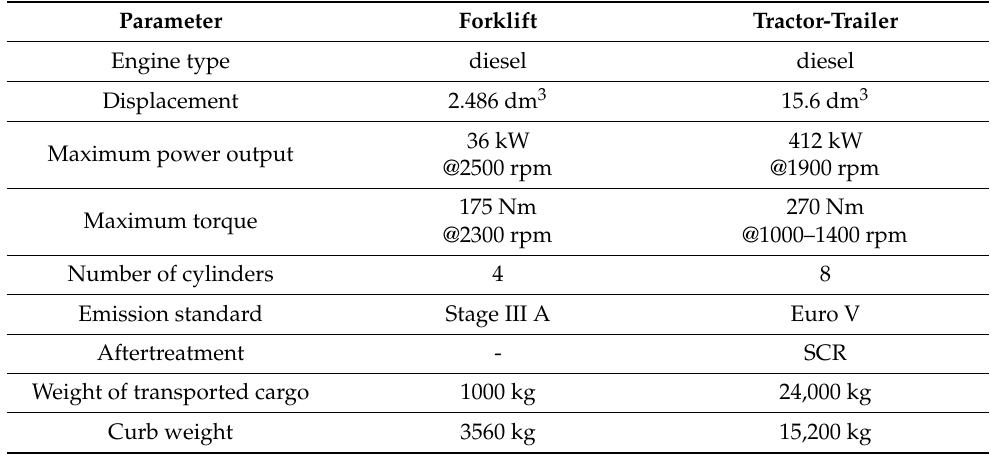
Table 1. Research object